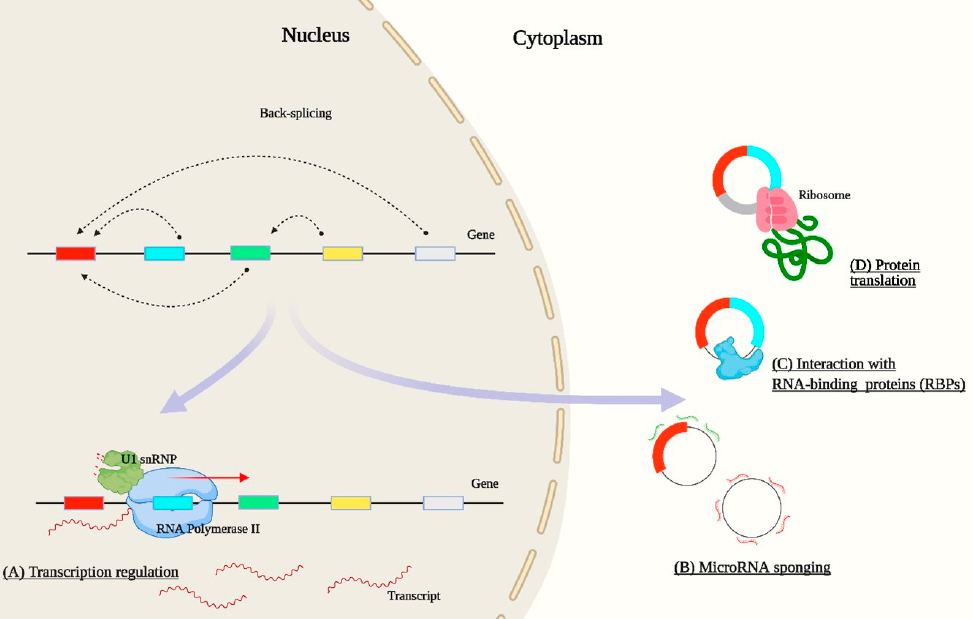
Figure 2. CircRNA functions. CircRNAs localized in the nucleus can regulate transcription ( A ), while their cytoplasmic counterparts can act as miRNA sponges ( B ), interact with proteins ( C ), and even regulate protein translation ( D ).